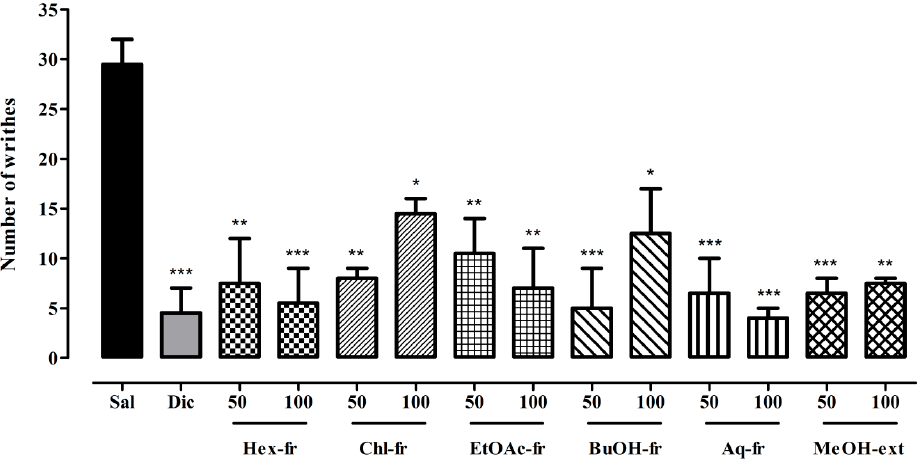
Figure 2. Antinociceptive activity of Trillium govanianum rhizome methanol extract and fractions in tonic visceral chemically-induced nociception. Values are expressed as mean ± SEM. ANOVA followed by Dunnett’s post hoc test: * p < 0.05, ** p < 0.01, *** p < 0.001 compared to saline treated group; N = 6. Dic = diclofenac.